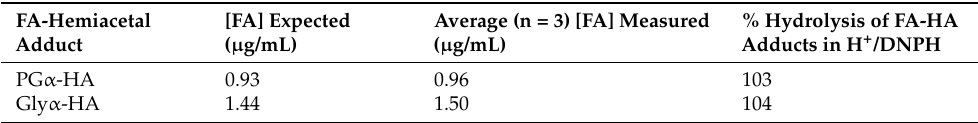
Table 2. Average (n = 3) conversion percentage of (Gly α -HA and PG α -HA) adducts to formaldehyde in acidic DNPH